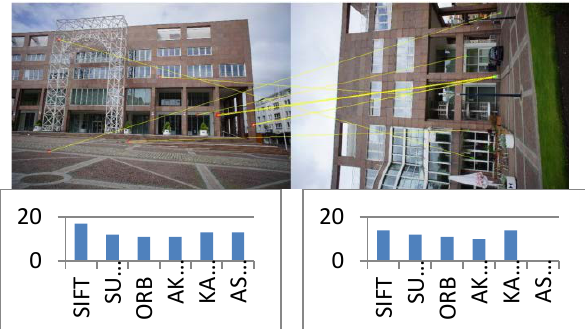
Figure 7: pair-5 results. Upper: ASIFT matches, lower: for each number of matches after E-/and F-based filtering (blue) and real inliers (red)